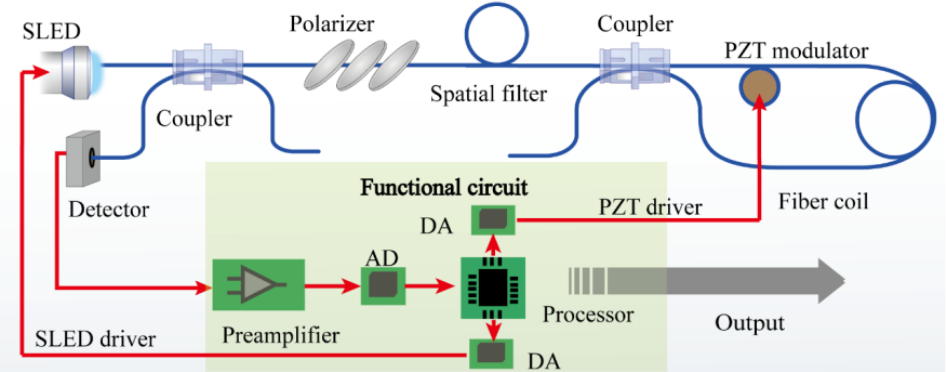
Figure 1. Scheme layout of an open-loop FOG.